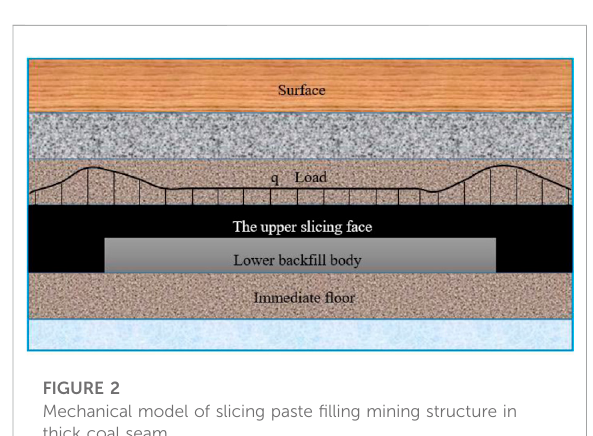
FIGURE 3 Mechanical force sketch of the roof of the fi lling